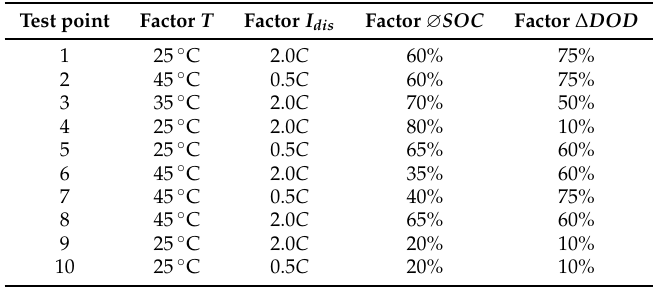
Table 5. Test matrix for test series B: Fractional factorial, D-optimal test design. Test